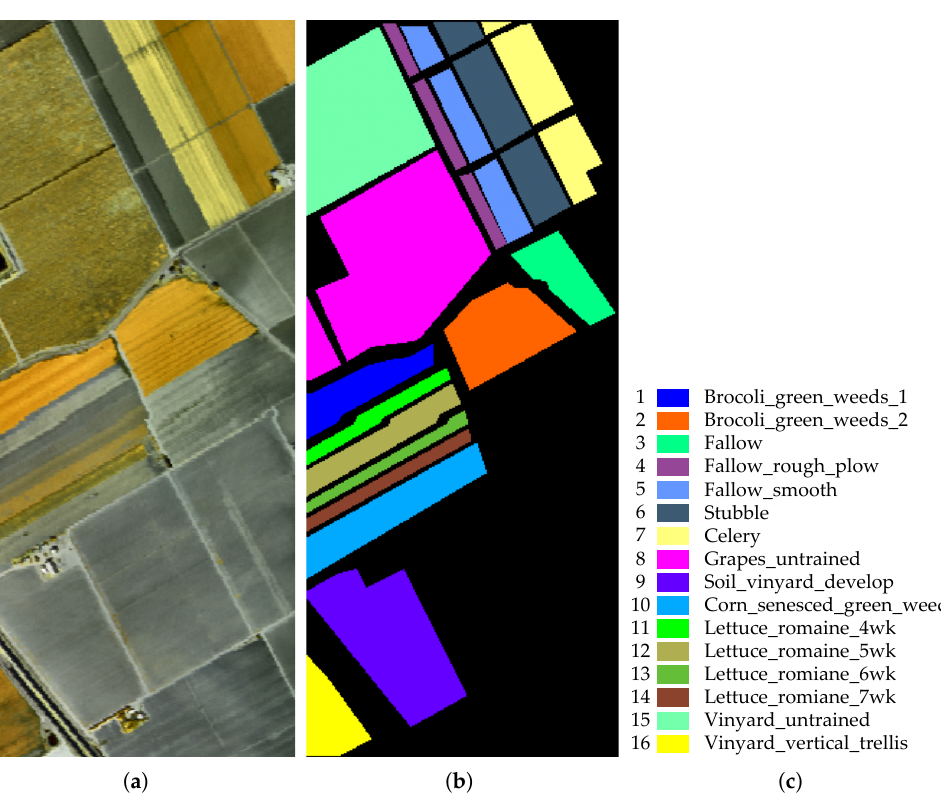
Figure 8. The Salinas Valley dataset. ( a ) The false-color image. ( b ) The ground-truth map. ( c ) The corresponding color